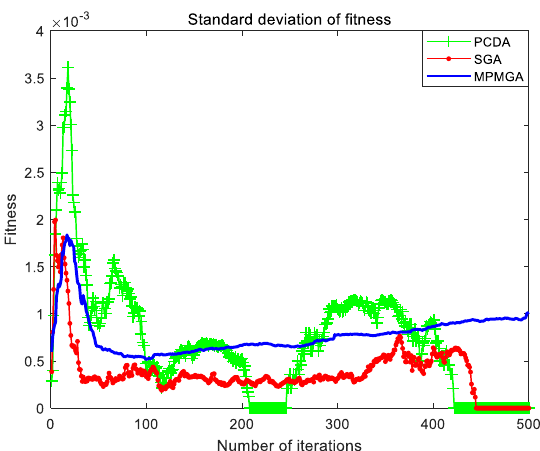
Figure 22. Evolutionary comparison diagram of population fitness standard deviation.